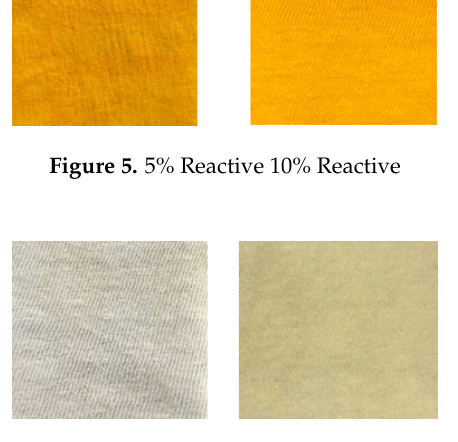
Figure 6. 5% Henna 10% Henna